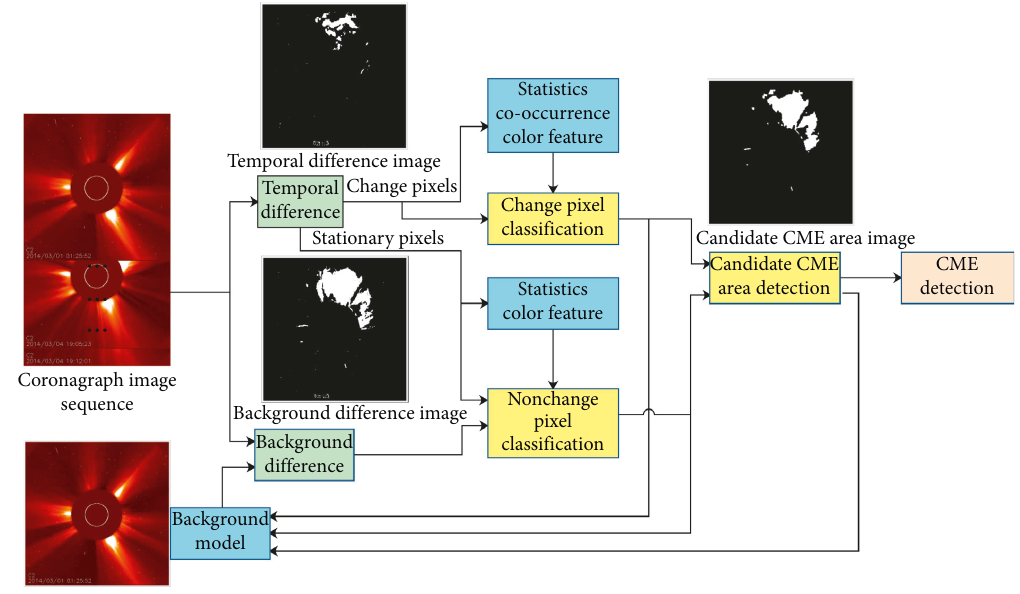
Figure 2: The block diagram of the candidate CME area